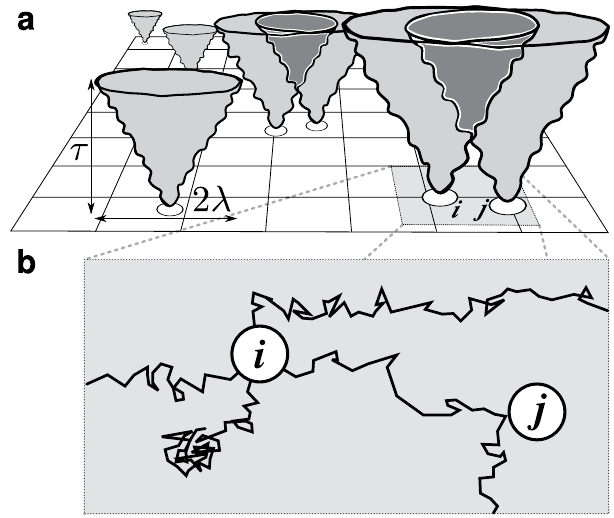
Figure 1. Schematic representation of a system of cognitive agents and their cognitive maps. ( a ) Starting from the initial condition in configuration space the agents (empty circles) create a cognitive map of their surroundings by means of hypothetical sampling trajectories of duration τ . The cones show a (2 + 1) -dimensional envelope of the trajectories, which represent the cognitive maps, of average radius λ . When the cones overlap, the agents sense each other and a force arises. ( b ) Shown here are four sampling trajectories emanating from cognitive agent i . As one of the trajectories impacts with agent j , agent i is forced to modify its trajectory, thus responding to its cognitive representation of the environment. Cognitive competence is the tendency to maximize the options left after one agent enters the space of the other, and to avoid in the most efficient way the overlapping